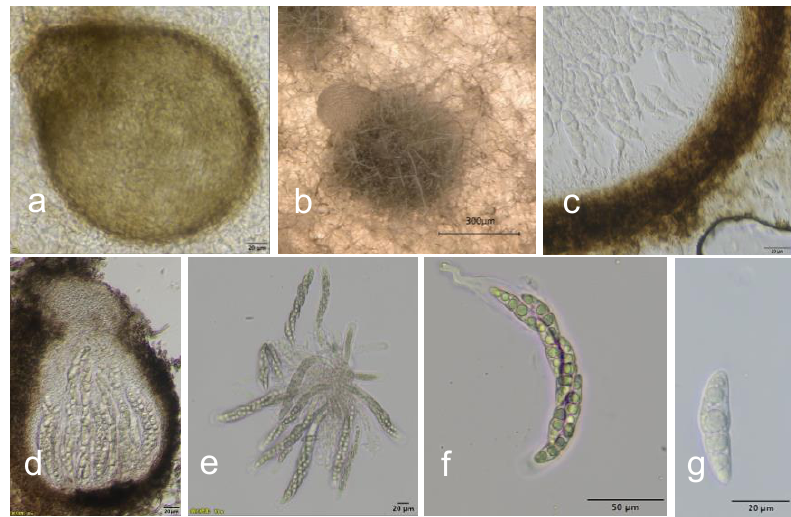
Figure 4. Microscopic characterization of asexual and sexual production of isolate SF007. The images on the top are asexual production on CMA medium and the images at the bottom are sexual production on SSA medium. ( a ). Pycnidium; ( b ). conidia oozing from the pycnidium; ( c ). the conidia grew in pycnidium; ( d ). ascoma in longitudinal section; ( e ). asci; ( f ). ascus; ( g ). ascospore. Scale bars: ( a , c , d , e , g ) = 20 μm; ( b ) = 300 μm; ( f ) = 50 μm.